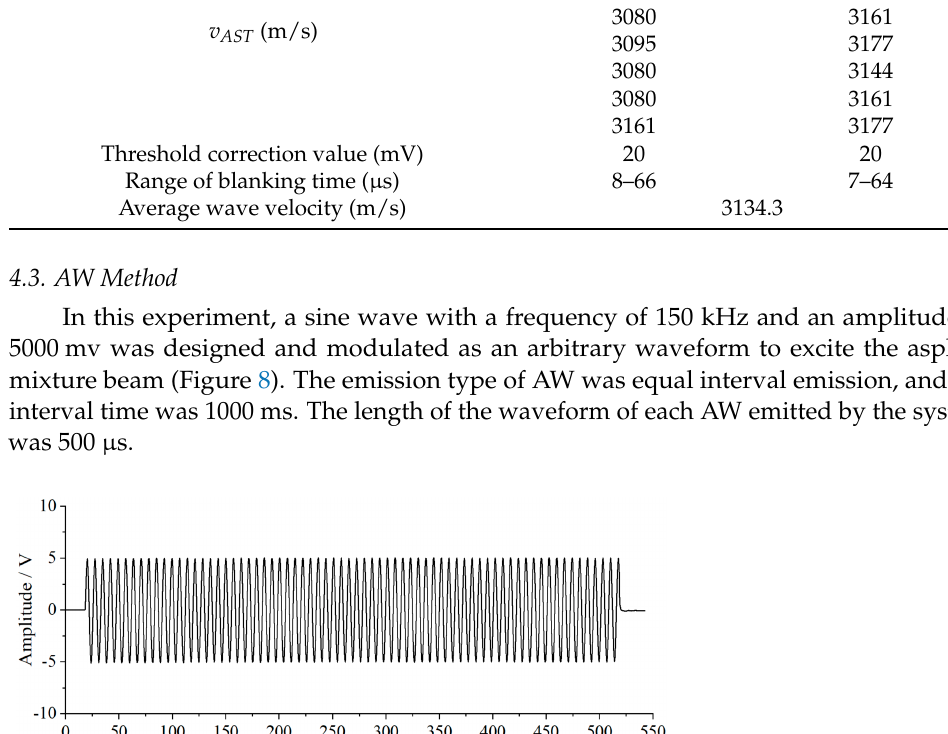
Table 2. Measurement results of the wave velocity by the AST method.